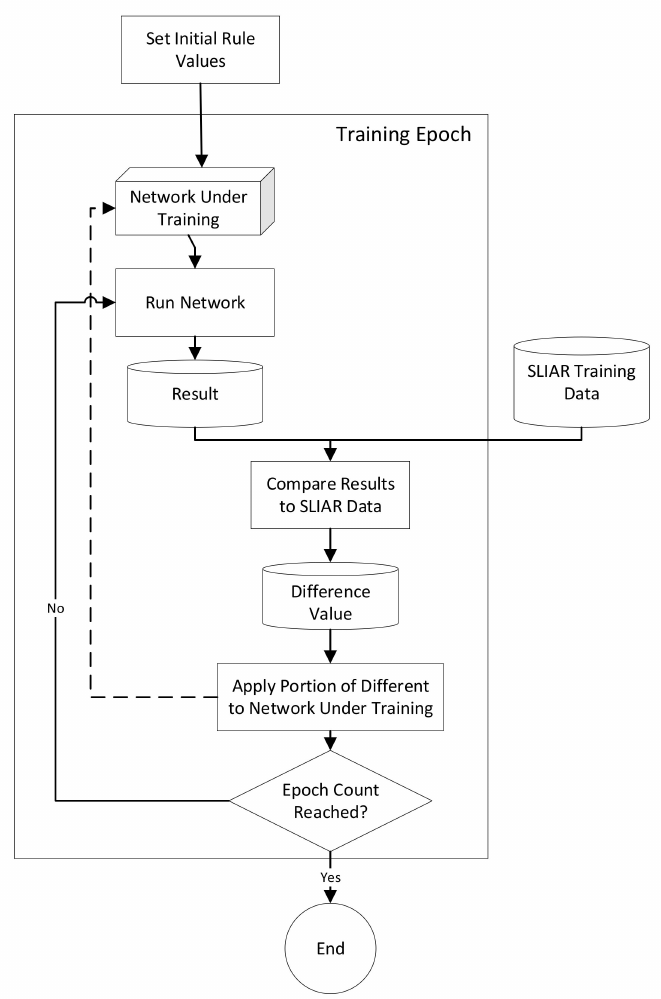
Figure 1. Training Process Using SLIAR Dataset (modified from